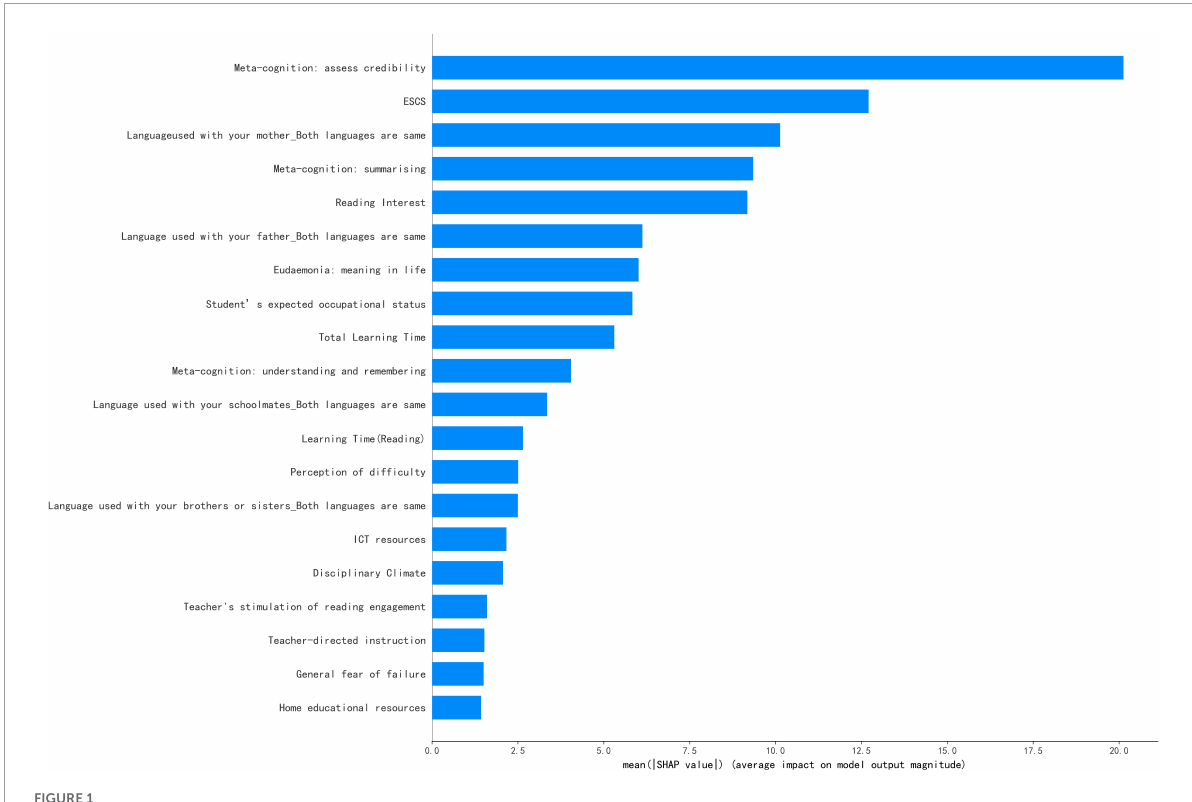
FIGURE1 The average absolute SHAP value indicates the feature